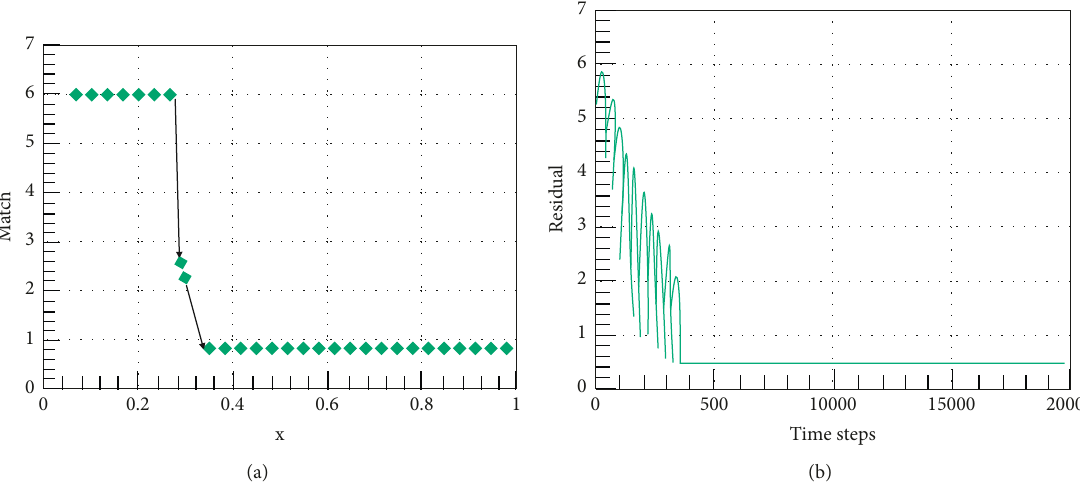
Figure 3: Animation frame profile calculated in HLLEM format ( M 0 � 6.0, ε � 0.5). (a) Mach number distribution curve. (b) Residual value convergence curve.